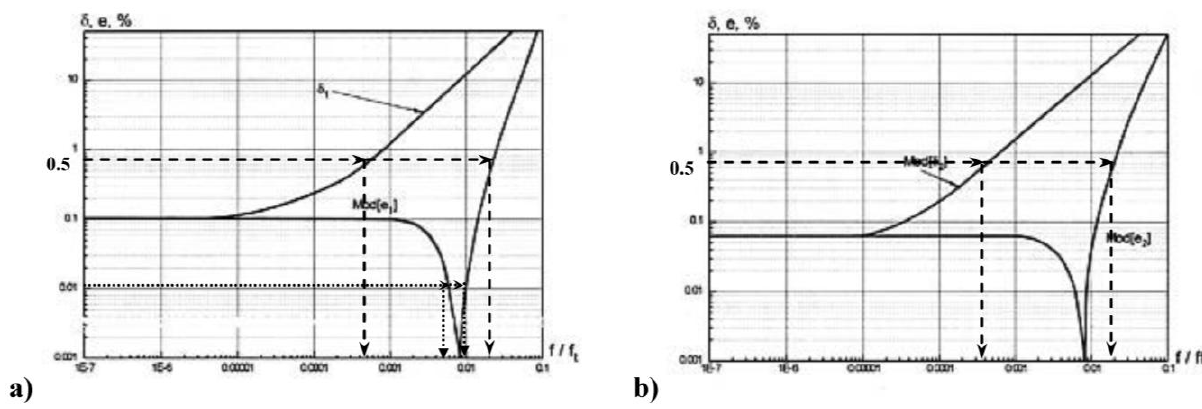
Figure 3. (a) Error behavior for active component of conductance measuring converter without (  ) and with ( e ) correction. (b) Error behavior for reactive component without (  1 1 and with ( e ) 2